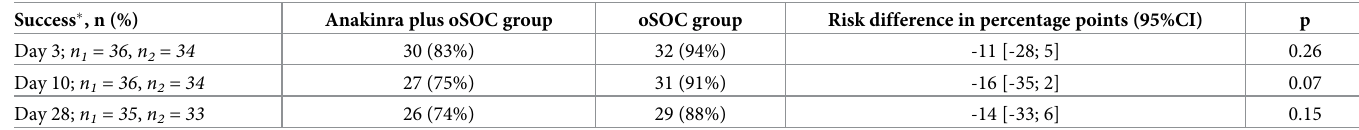
C-reactive protein, ferritin, fibrinogen and D-dimers levels decreased over time in the two groups, while the lymphocyte count increased in both groups (S3 Fig). No between-group dif- ference was found in the evolution of inflammatory parameters. Table 3. Number (percentage) of participants alive and without need of mechanical ventilation or ECMO at day 3, 10 and 28. Success � , n